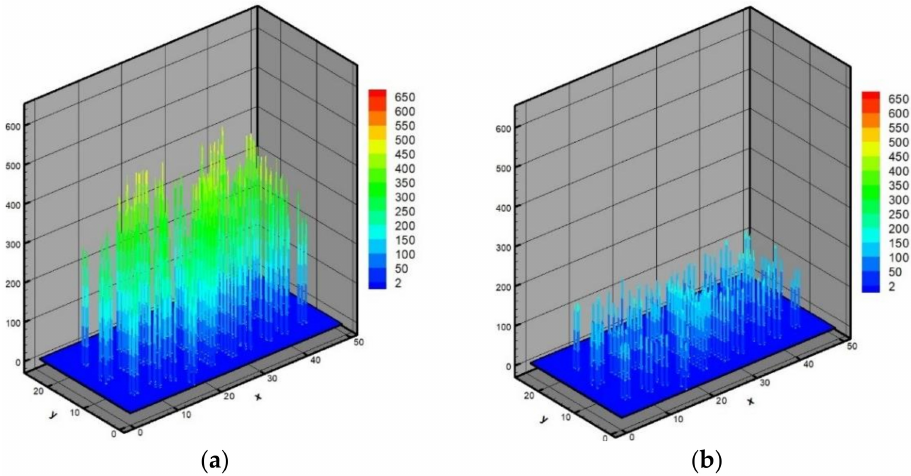
Figure 11. Bearing capacity of piles in April 2021 ( a ) and in September 2021 ( b ) in tf/m 2 .